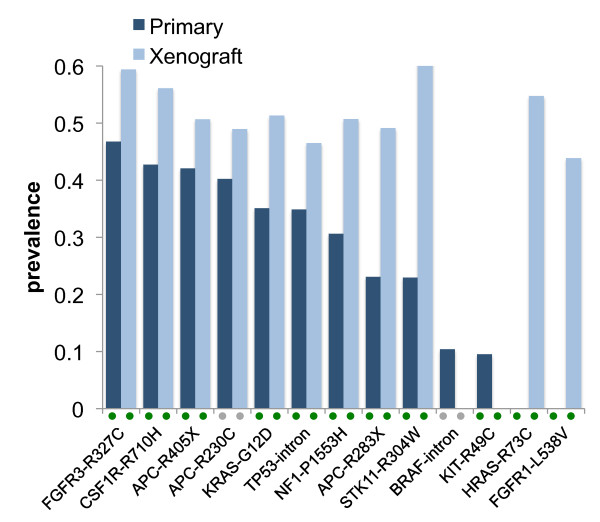
Mutational profiles of the colon primary and xenograft tumor samples. Histogram showing the prevalence of the 11 colon primary (dark blue) and 11 xenograft (light blue) mutations. In the primary tumor, ten of the mutations were identified using the UDT-Seq method and one (STK11-R304W) by visual inspection of the reads after it was observed in the xenograft. All mutations validated by a sequence-based assay (SNaPshot or Sanger) are indicated by a green dot. Mutations not examined by independent assay are indicated by a grey dot.